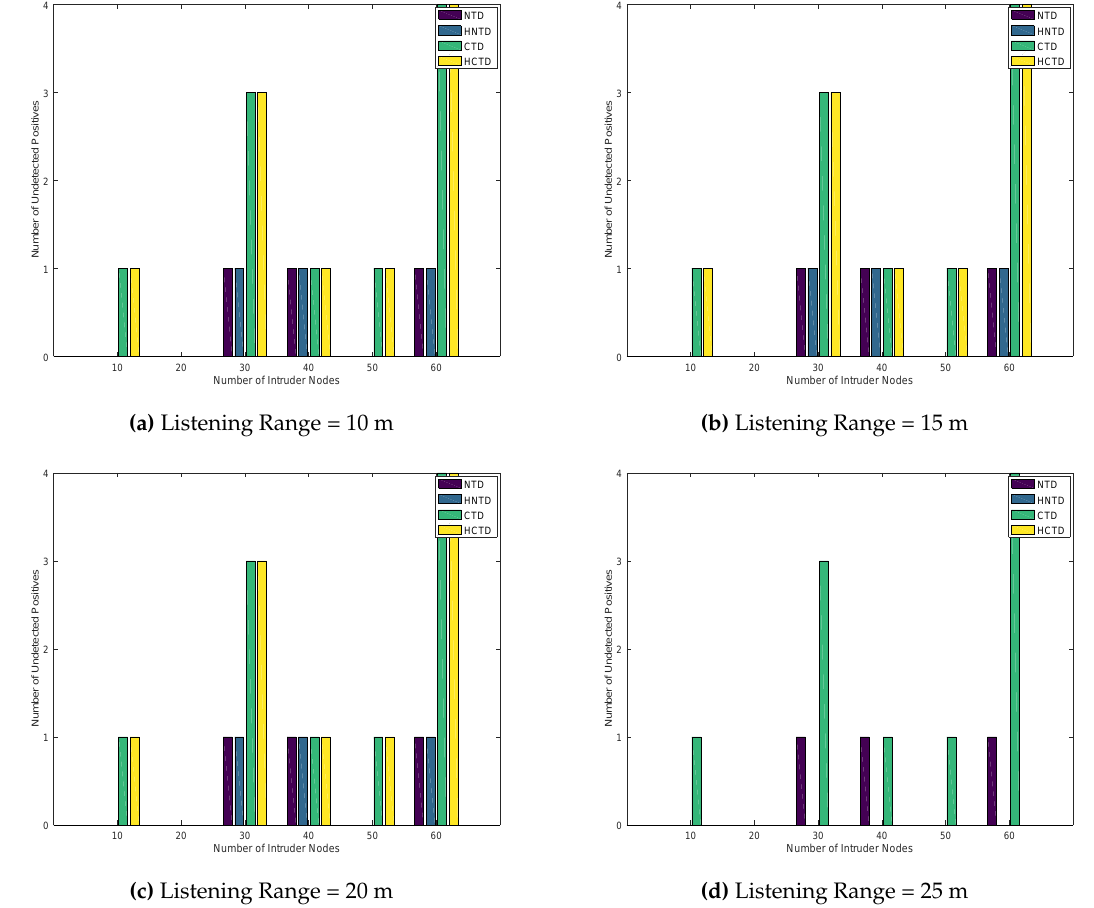
Figure 13. Number of Undetected Positives for Randomly placed